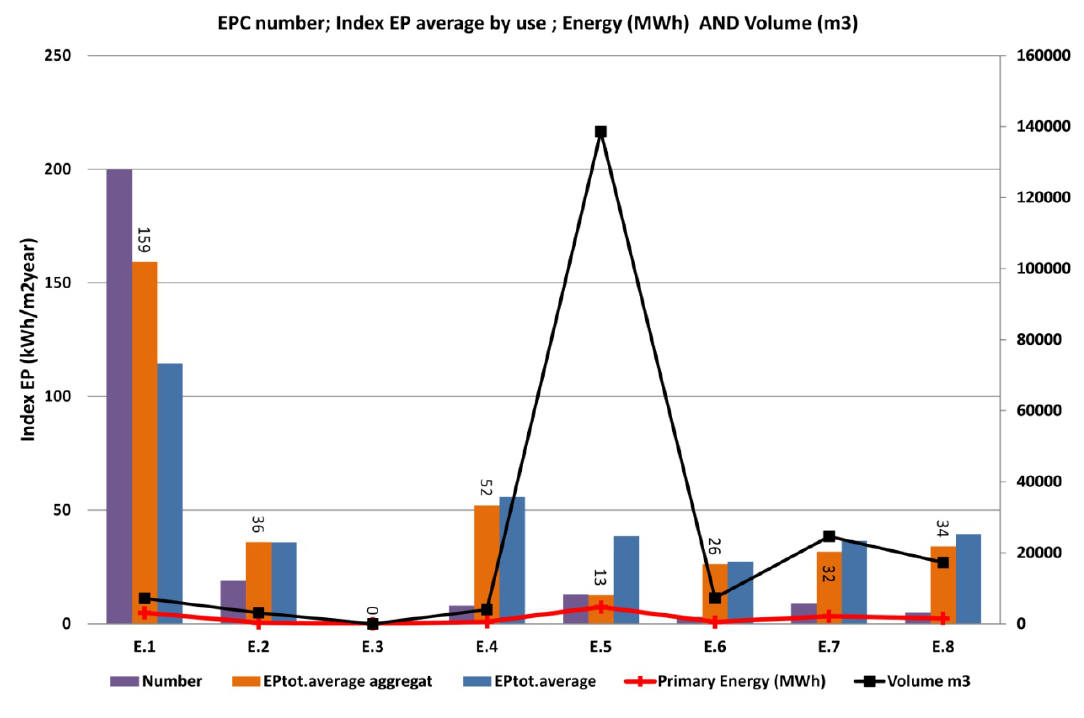
Figure 2. Comparison between number of building, AIEP gross